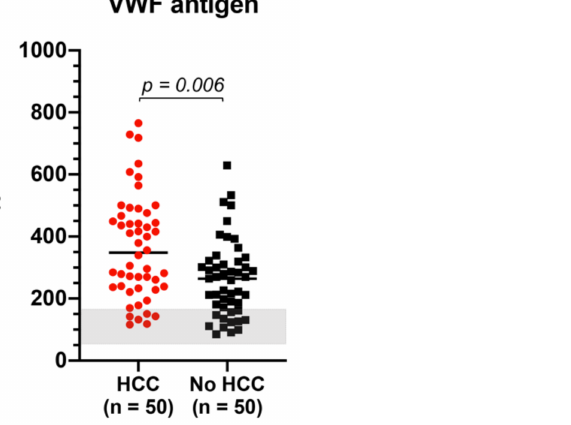
Figure 5. Levels of Von Willebrand factor are significantly increased in patients with vs. without HCC. Legend: HCC: hepatocellular carcinoma. Grey area refers to reference range in healthy subjects (50–160%). Red circles: patients with cirrhosis with HCC. Black squares: patients with cirrhosis without